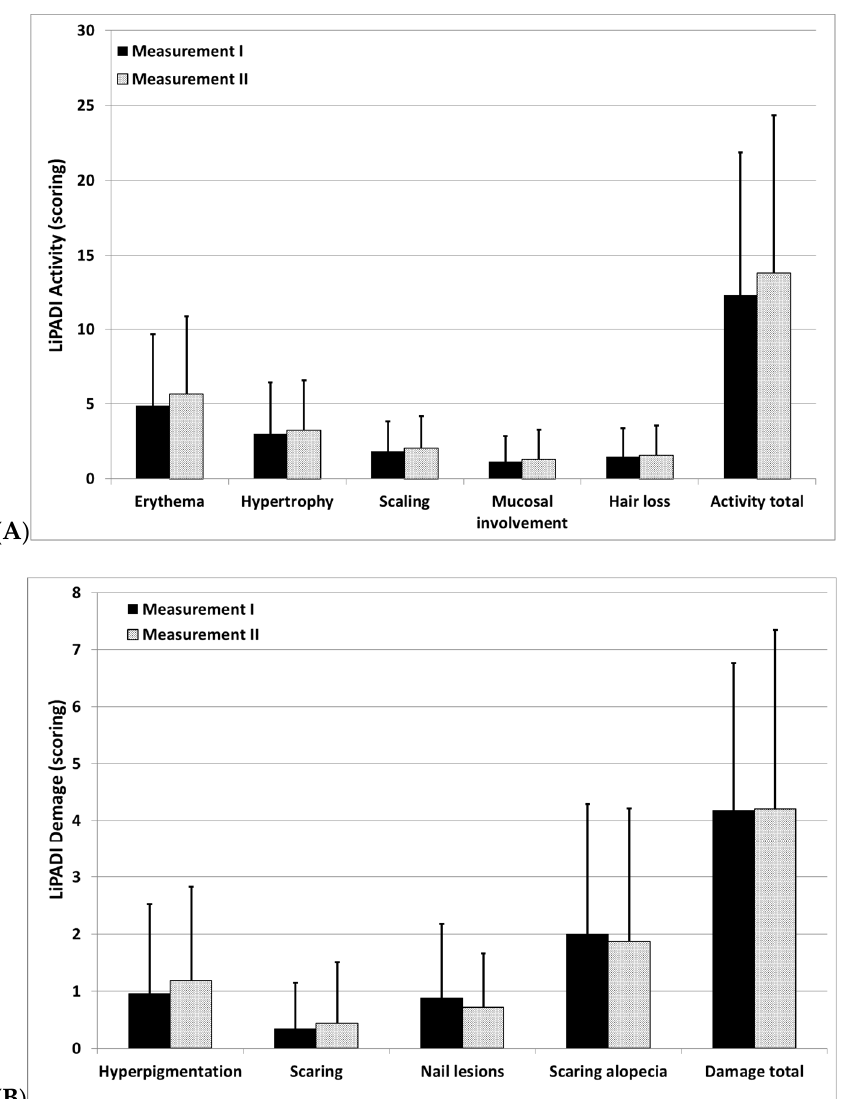
Figure 1. ( A ) Comparison of the scoring of total LiPADI activity and its subdomains performed by two independent assessors. ( B ) Comparison of the scoring of total LiPADI damage and its subdomains performed by two independent assessors (results demonstrates as means ± standard deviations, p > 0.05 for all comparisons).